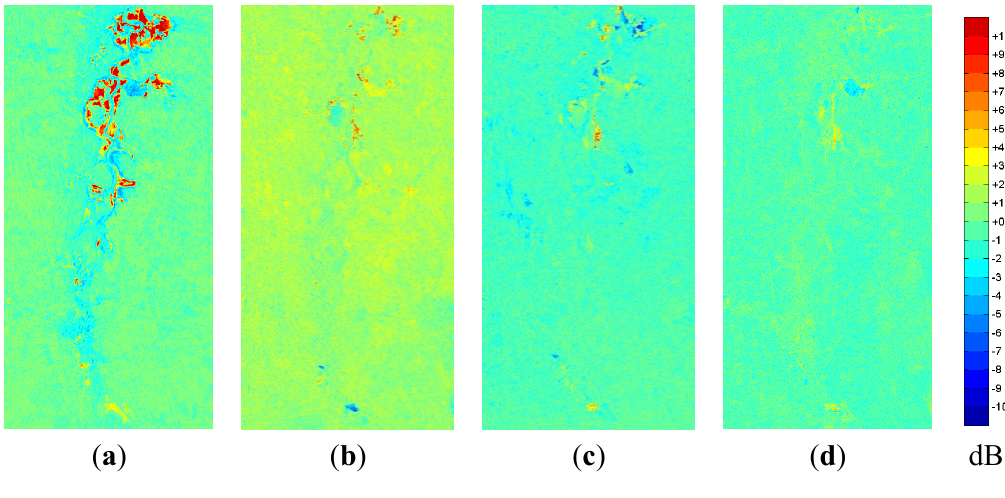
Figure 10. Change in Kennaugh Element k